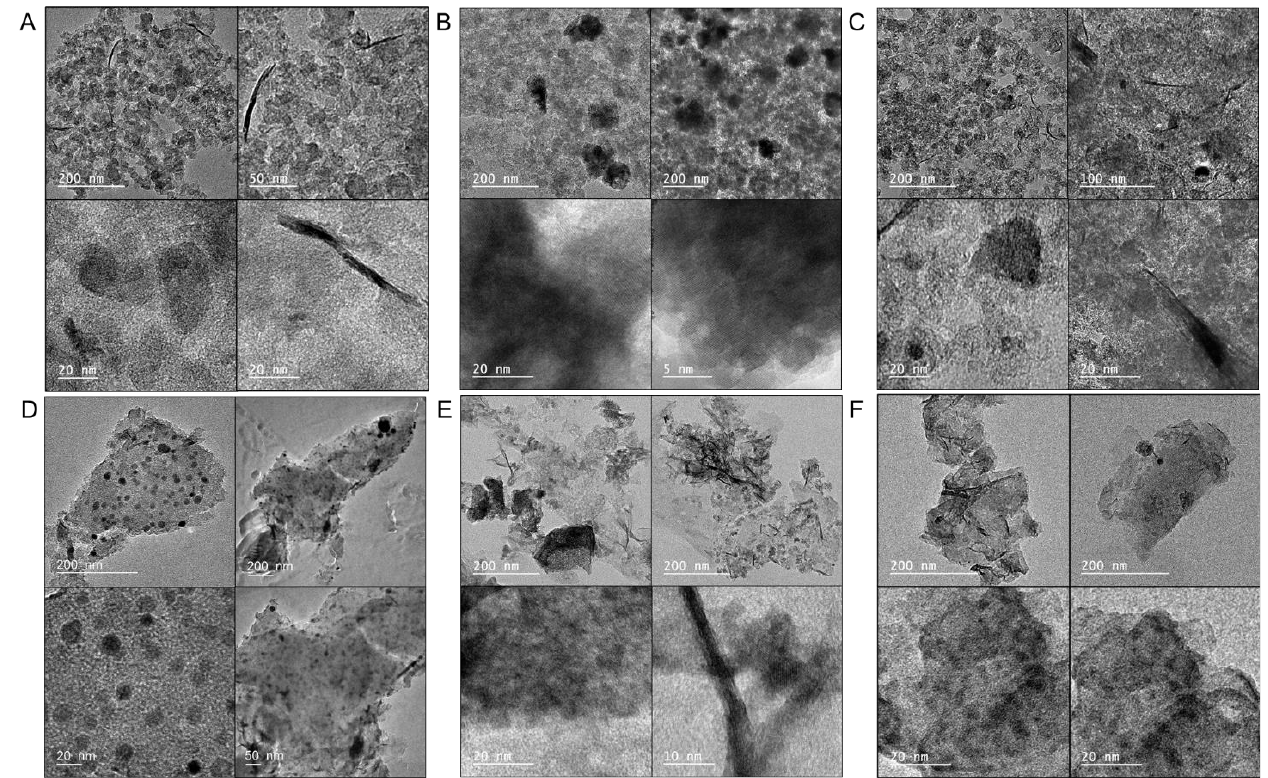
Figure 6. TEM images of BP-Ni ( A ); BP-Co ( B ); BP-NiCo ( C ); BAX-Ni ( D ); BAX-Co ( E ); and BAX-NiCo ( F ).